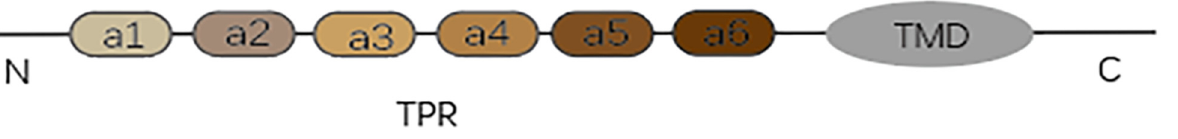
rings; residues Val11-Ala27, Lys32-Val43, Asn48-Leu62, Lys67-Arg83, Tyr87-Thr100, Asn105-Lys120 form α 1, α 2, α 3, α 4, α 5, α 6, respectively. The TMD region is responsible for the location of FIS1.